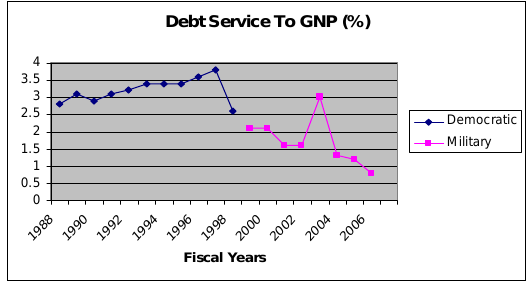
Graph 3 Source: Different economic surveys of Pakistan Graph 4 below shows total debt to GNP (%) for Pakistan for the period falling between FY1988 and FY2007. The ratio hovered at the same mark till 2001; this is when the trend saw a decrease at the back of strong GNP growth and post 9/11-debt assistance championed by the USA.